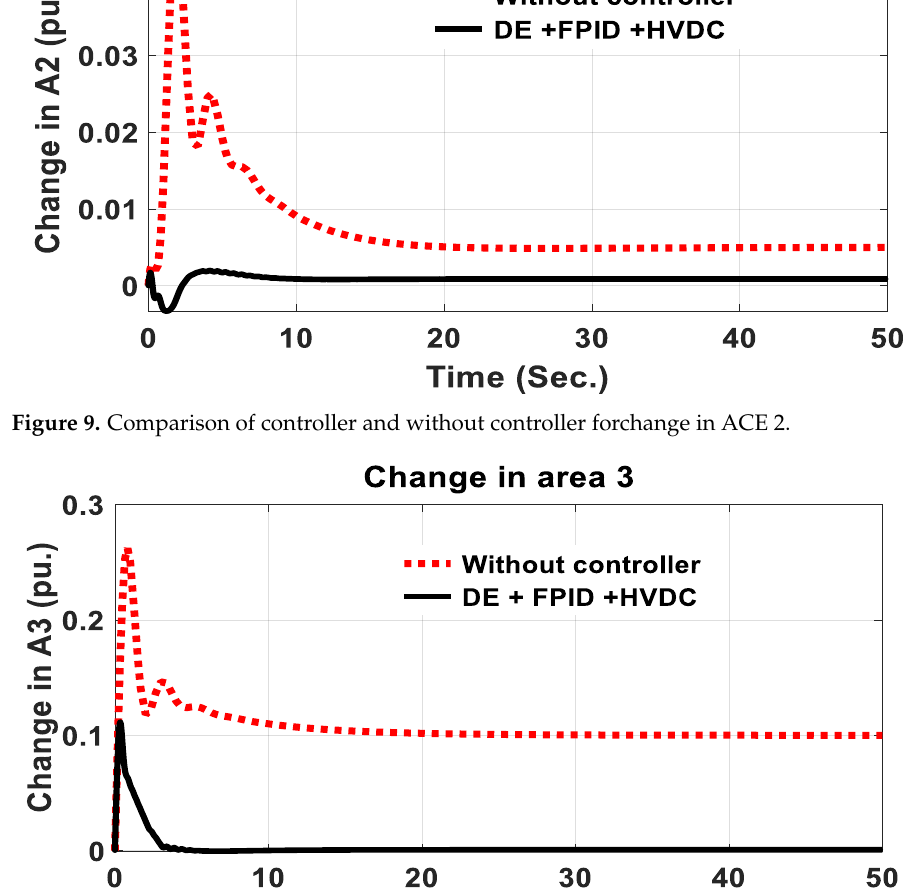
Figure 11. Comparison of controller and without controller + HVDC for change in tie-line power deviation P13. Figure 12. Comparison of controller and without controller + HVDC for change in tie-line power deviation P12.